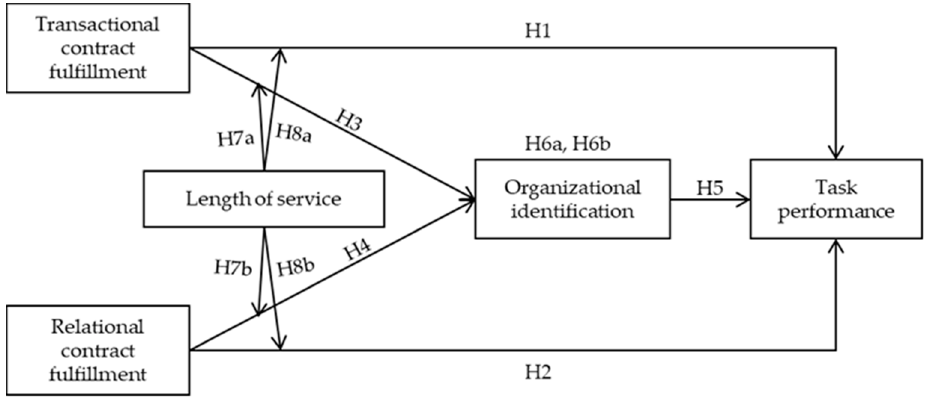
Figure 1. Research model.